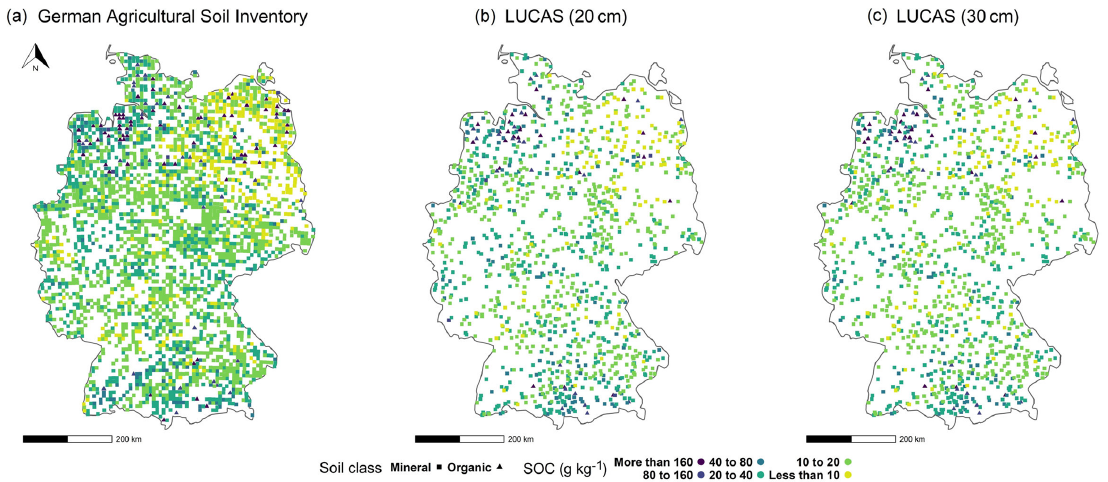
Figure 1. Soil organic carbon content in the topsoil of two soil inventories: (a) the German agricultural soil inventory (0–30cm) and (b) LUCAS at its original sampling depth (0–20cm) and (c) after depth extrapolation (0–30cm).